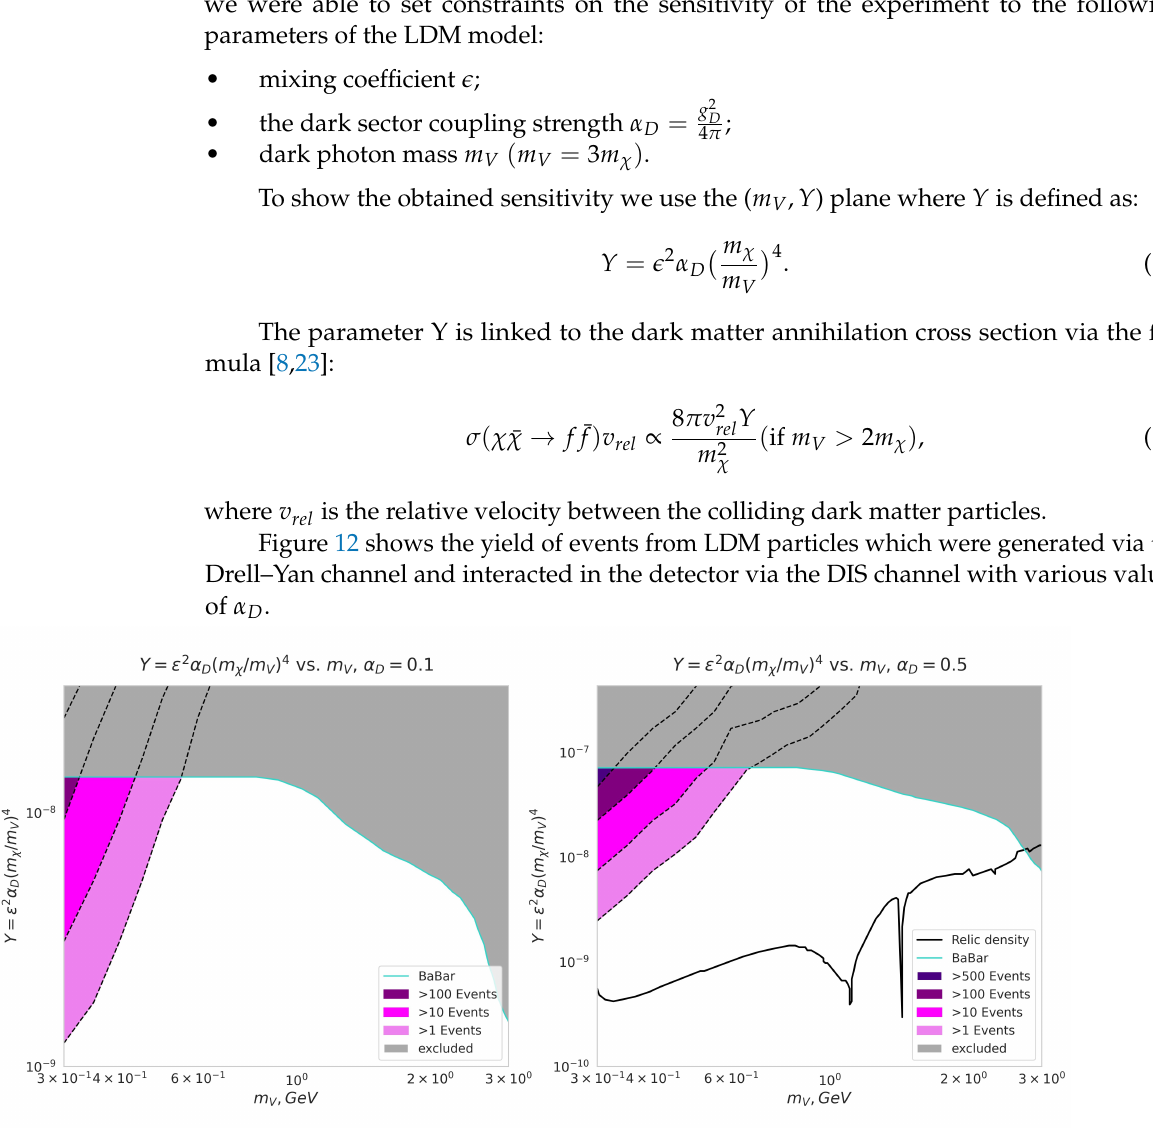
Figure 12. The yield of events from LDM particles which were generated via the Drell-Yan channel and interacted in the detector via the DIS channel with various values of α D (purple regions). The gray regions are excluded by the existing constraints (e.g., the ones obtained in the BaBar experiment [24]), and the dark curve shows the relic density behavior [23] at various Y and m V